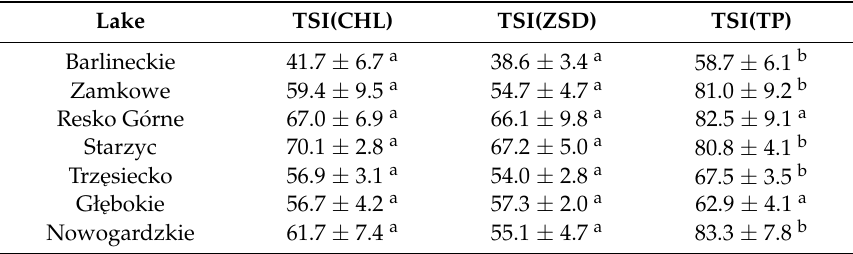
Table 4. Mean values of Carlson’s Trophic State Indices: TSI(SD), TSI(TP), TSI(CHL) of the tested lakes calculated for the entire study period. Different letters (a, b) indicate significant differences between the mean TSIs calculated for the individual lake ( α =